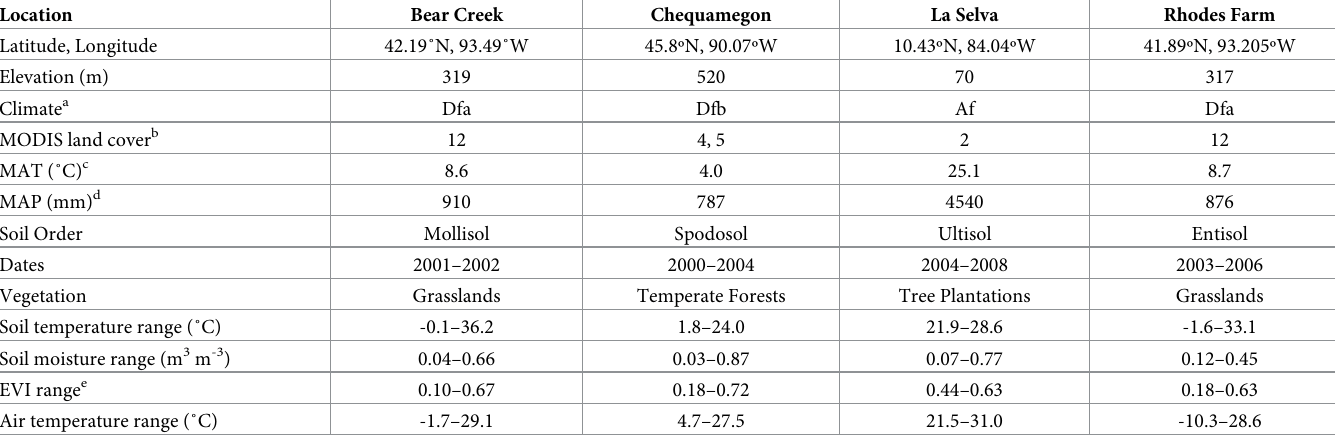
Table 1. Environmental characteristics of the four study